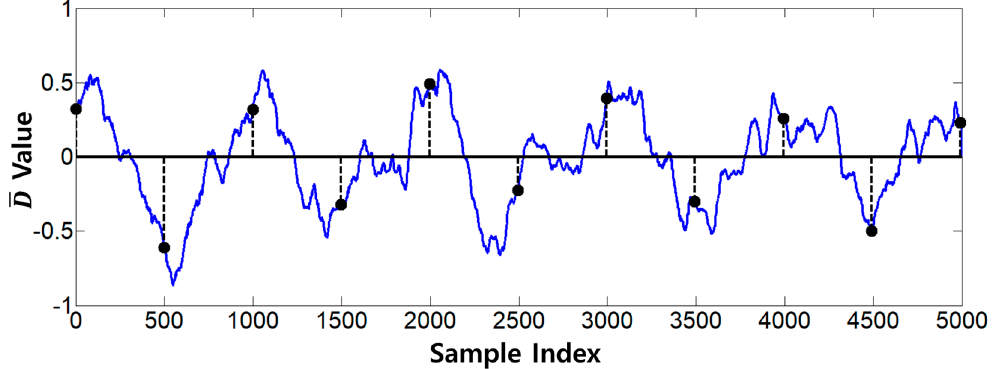
Figure 15. Correlation D values calculated for each of 5000 samples of “Drama” audio after HE-AAC v1 24kbps, where the watermark bit [1, 0, 1, 0, 1, 0, 1, 0, 1, 0] is embedded.